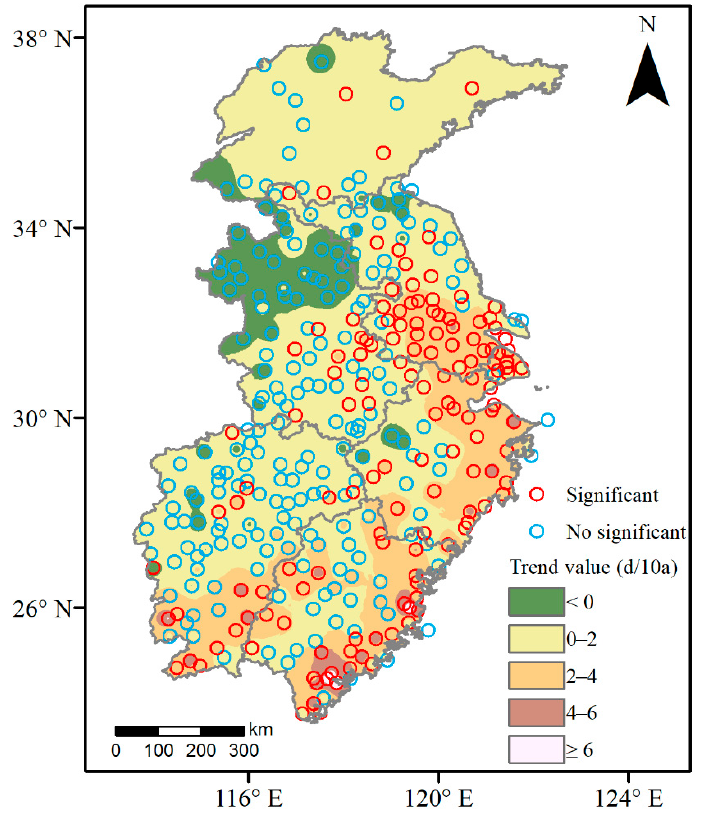
Figure 4. Climate tendency rate and significant variation distribution of the annual number of EMTE days in East China during the period 1961–2020.